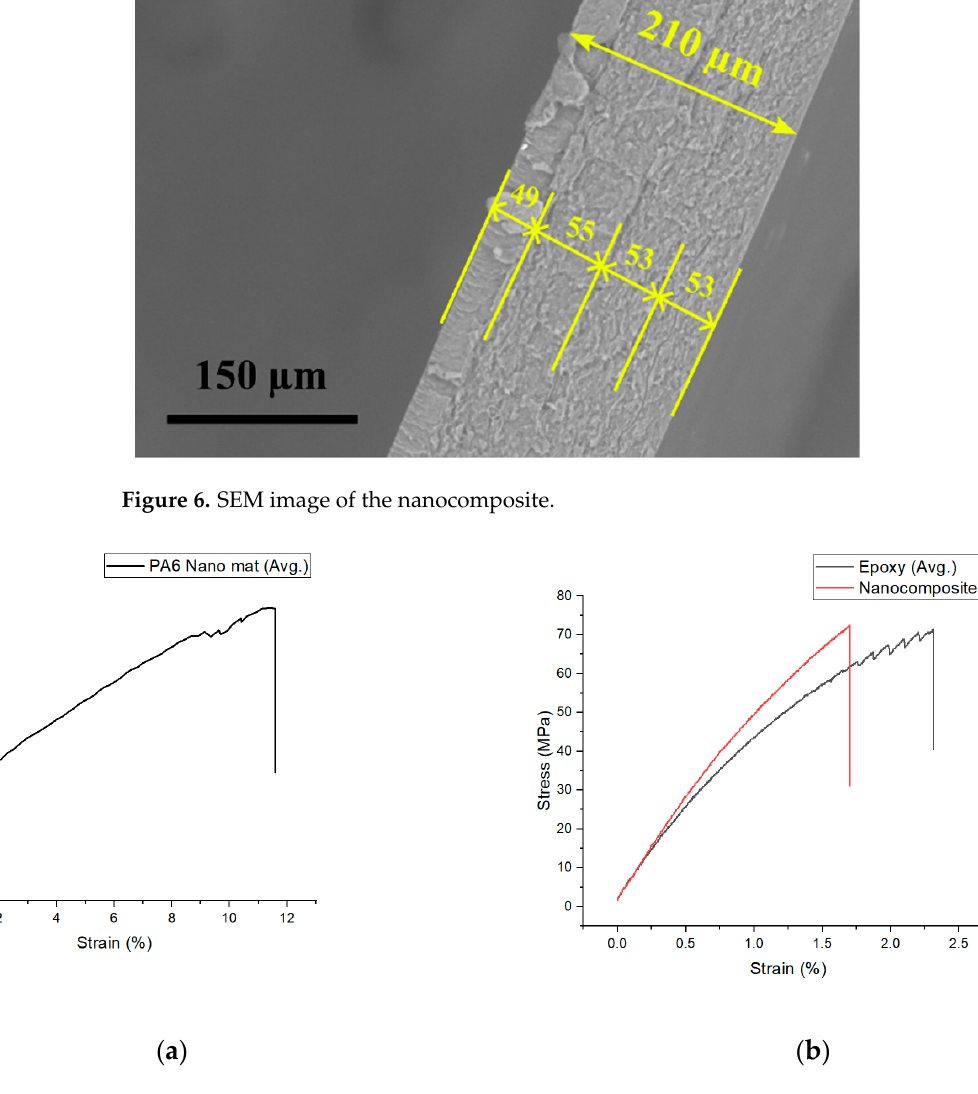
Figure 6. SEM image of the nanocomposite.